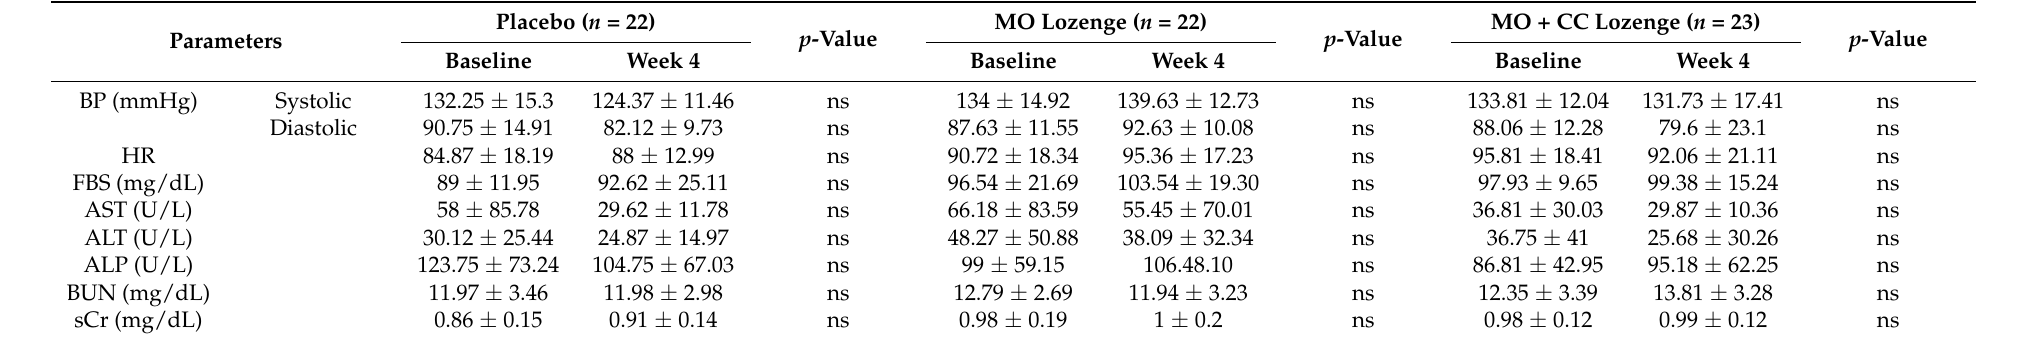
Table 4. Laboratory examination of smokers at baseline and week 4. The different of blood pressure (BP) and heart rate (HR) were analyzed using paired T-test ( p < 0.05). The different of fasting blood sugar (FBS), aspartate aminotransferase (AST), alanine aminotransferase (ALT), alkaline phosphatase (ALP), blood urea nitrogen (BUN), and serum creatinine (sCr) were analyzed by Wilcoxon signed rank test at the p < 0.05 level. The values are the mean ± SD and ns is not significant. MO: Moringa oleifera ; CC: Cyanthillium cinereum